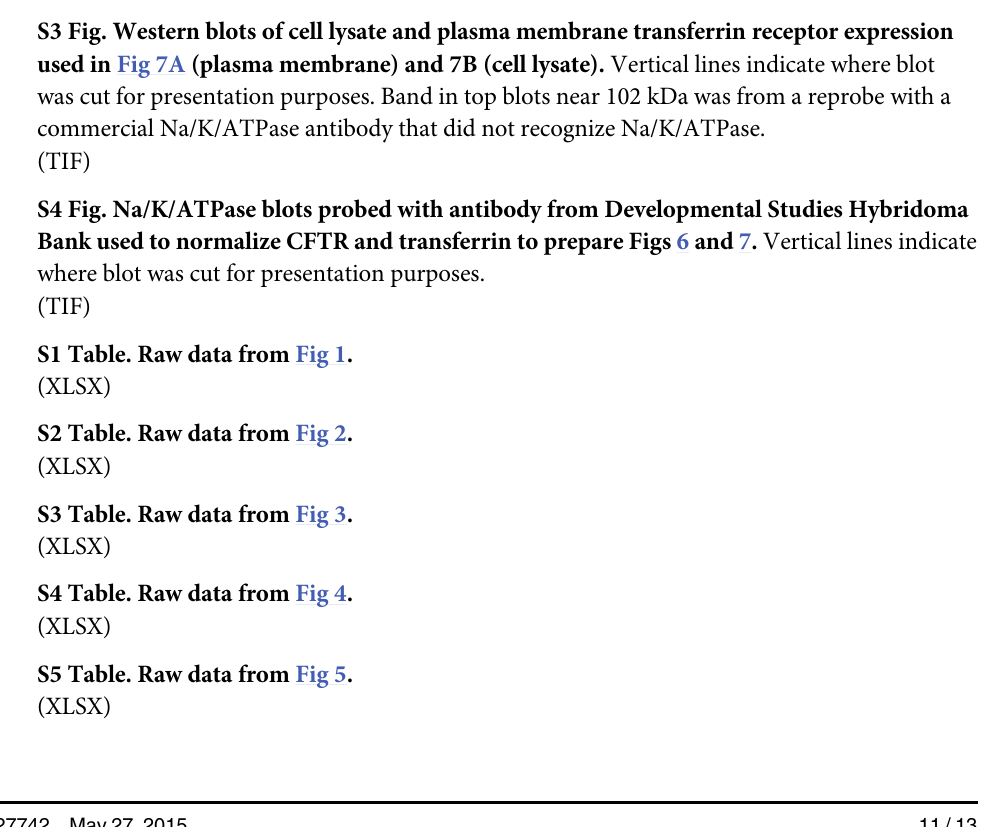
S3 Fig. Western blots of cell lysate and plasma membrane transferrin receptor expression used in Fig 7A (plasma membrane) and 7B (cell lysate). Vertical lines indicate where blot commercial Na/K/ATPase antibody that did not recognize Na/K/ATPase. S4 Fig. Na/K/ATPase blots probed with antibody from Developmental Studies Hybridoma Bank used to normalize CFTR and transferrin to prepare Figs 6 and 7. Vertical lines indicate where blot was cut for presentation purposes. S1 Table. Raw data from Fig 1. S2 Table. Raw data from Fig 2. S3 Table. Raw data from Fig 3. S4 Table. Raw data from Fig 4. S5 Table. Raw data from Fig